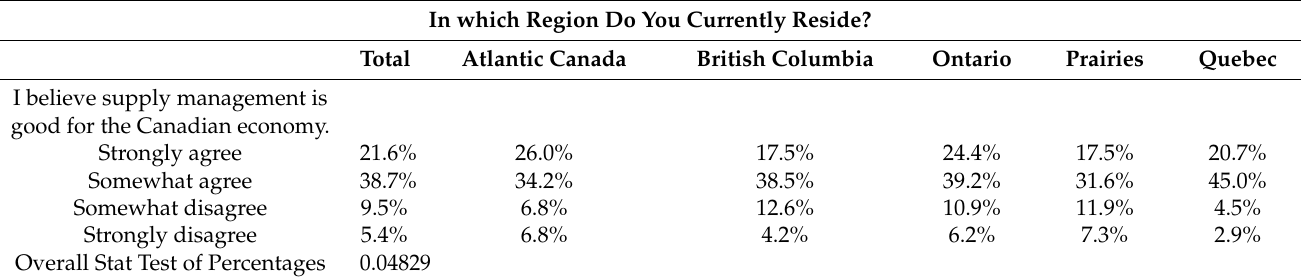
Table 1. I believe supply management is good for the Canadian